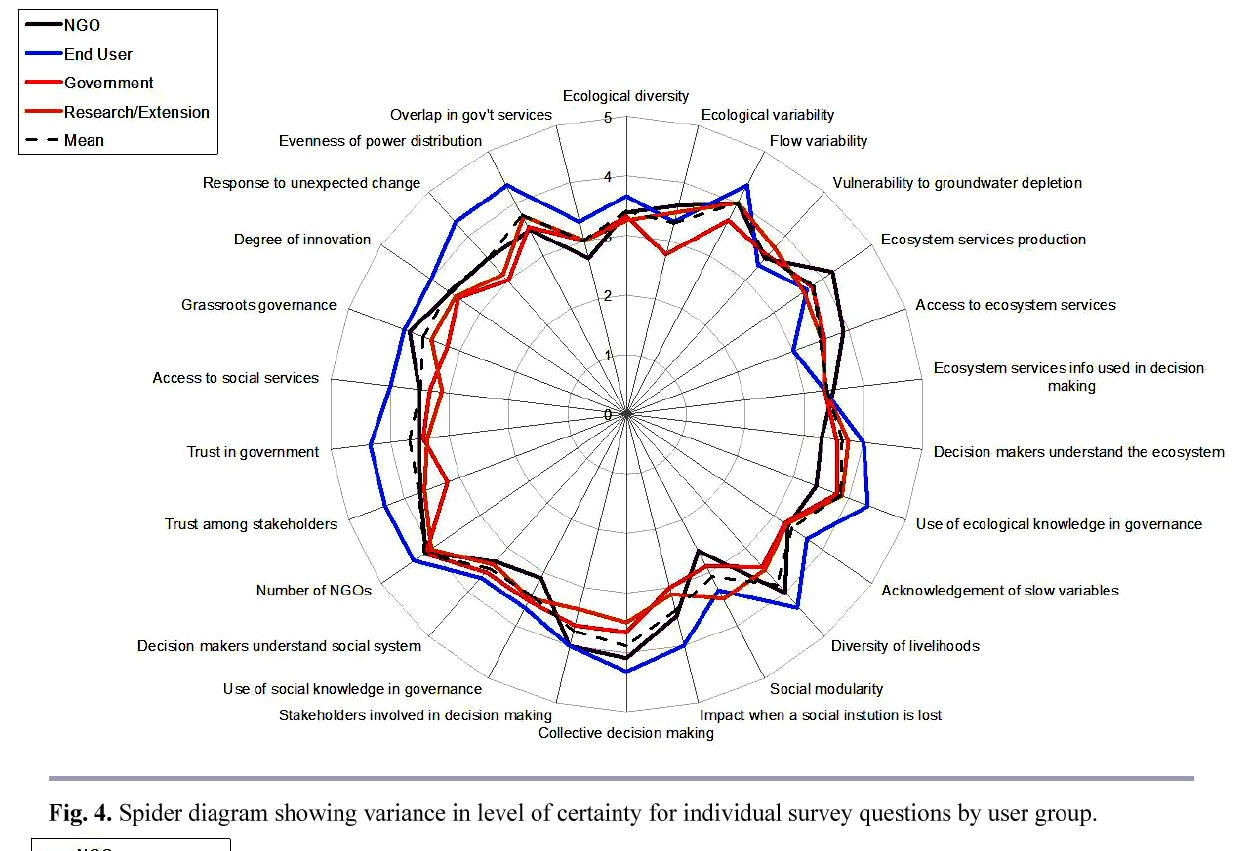
Fig. 3 . Spider diagram showing average certainty in response for individual survey questions by user